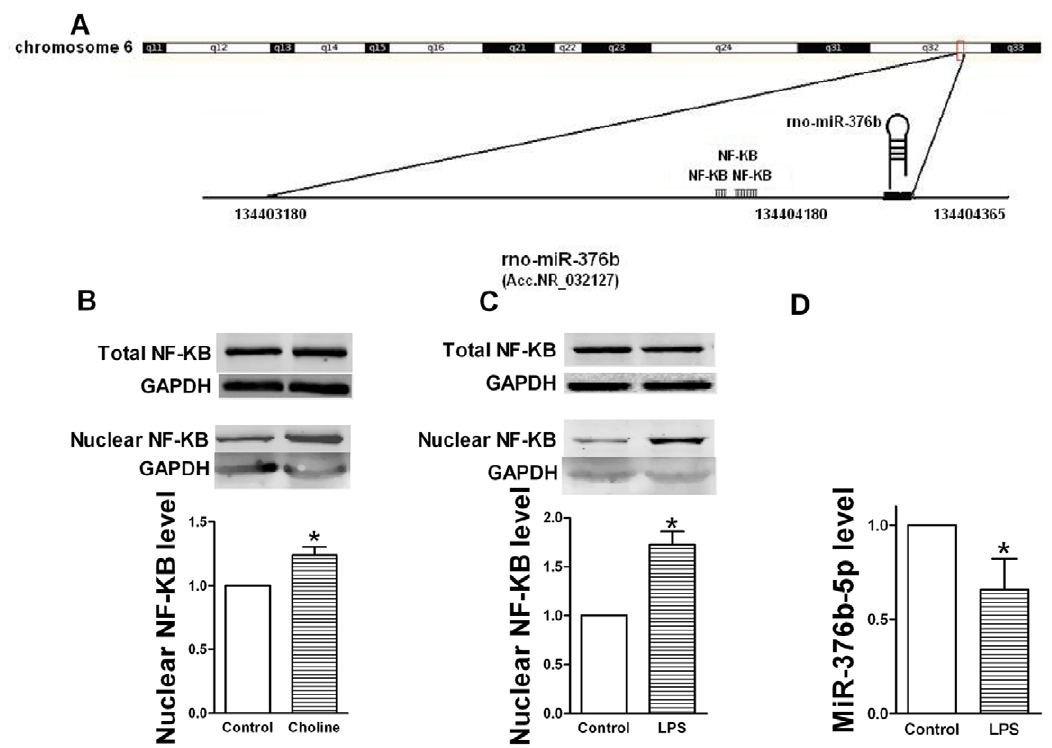
Figure 5. NF- k B mediates the inhibitory effect of M 3 -mAChR on miR-376b-5p expression. GAPDH as an internal control normalized NF- k B band for western blot. U6 as an internal control normalized miR-376b-5p for quantitative real-time RT-PCR (qRT-PCR). (A) Chromosomal organization of the miRNA-376b gene locus on rat chromosome 6q32 indicating three NF- k B binding sites in the pre-miR-376b gene promoter. (B) Choline activated NF- k B in H9c2 cells. Top, representative Western blots of total NF- k B; Middle, representative Western blots of nuclear NF- k B; bottom, quantitation of nuclear NF- k B as mean 6 SEM Note: n=4; * P , 0.05 versus Control. (C) LPS activated NF- k B in H9c2 cells. Top, representative Western blots of total NF- k B; Middle, representative Western blots of nuclear NF- k B; bottom, quantitation of nuclear NF- k B as mean 6 SEM. Note: n=6; * P , 0.05 versus Control. (D) LPS inhibited miR-376b-5p expression in H9c2 cells. MiR-376b-5p expression was determined by qRT-PCR. Values were expressed as mean 6 SEM; n=5; * P , 0.05 vs.